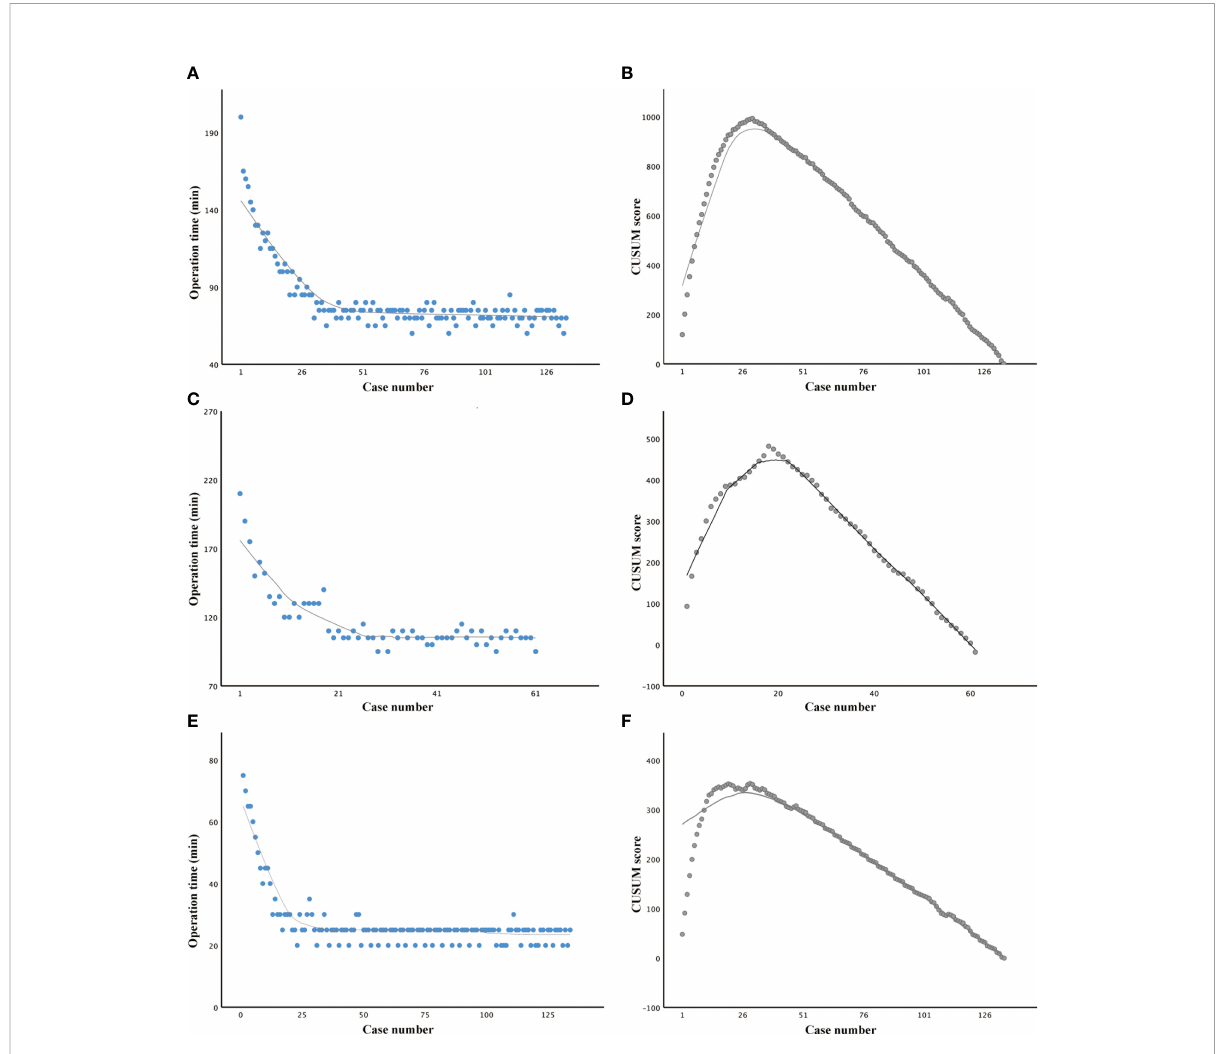
FIGURE 2 Learning curve studies of robotic thyroid surgery via the bilateral axillary breast approach. (A, B) Operation time plotted in chronological order and cumulative summation (CUSUM) test in patients who underwent lobectomy. (C, D) Operation time plotted in chronological order and CUSUM test in patients who underwent total thyroidectomy. (E, F) Operation time plotted in chronological order and CUSUM test in work spacing